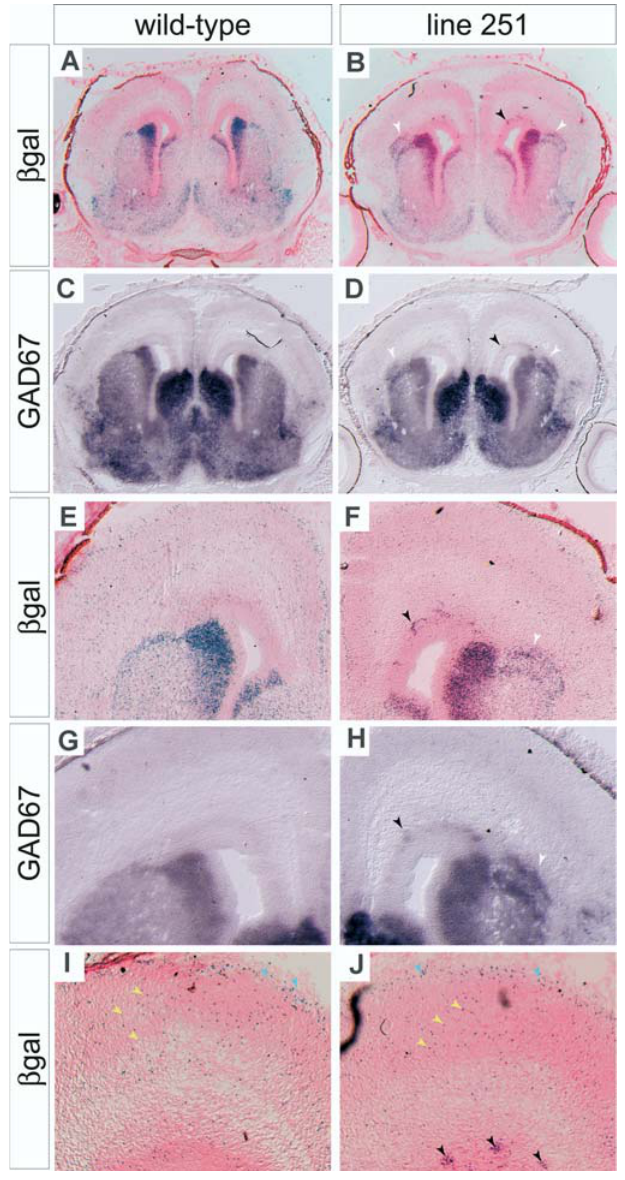
Figure 6. Dlx-LacZ and GAD67 Expression Show that Interneuron Precursors Persist in the IZ/SVZ of 251 Mutant Cortices (A) Coronal section through the forebrain of an E18.5 WT embryo stained for b -galactosidase and counterstained with nuclear fast red. (B) A similar section from a line 251 mutant embryo. Unusual accumulations of stained cells can be seen in the cortex just dorsal to the striatum (white arrowheads). Aggregates of cells in the IZ/SVZ can also be seen (black arrowhead). (C and D) Sections adjacent to those in (A) and (B) hybridized with a probe for Gad67 mRNA. Arrowheads in (D) point to the same features that are seen in (B). (E–H) Higher-magnification views of the dorsal portions of the sections in (A–D). (I and J) Higher-magnification view of cortex. In the WT cortex (I), cells can be seen dispersed through the cortical plate (yellow arrowheads) and scattered through the MZ (blue arrowheads). Similar distributions of labeled cells can be seen in the mutant cortex (J). In contrast to the WT, however, aggregates of cells are found in IZ/SVZ (black arrowheads). DOI: 10.1371/journal.pbio.0020219.g006